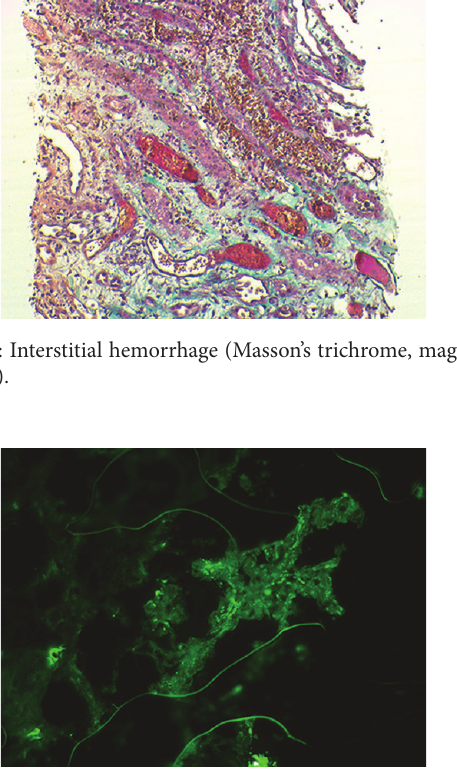
Figure 3: Direct immunofluorescence showing granular mesangial staining for IgA in the expanded mesangium of the biopsy, magnifi- cation